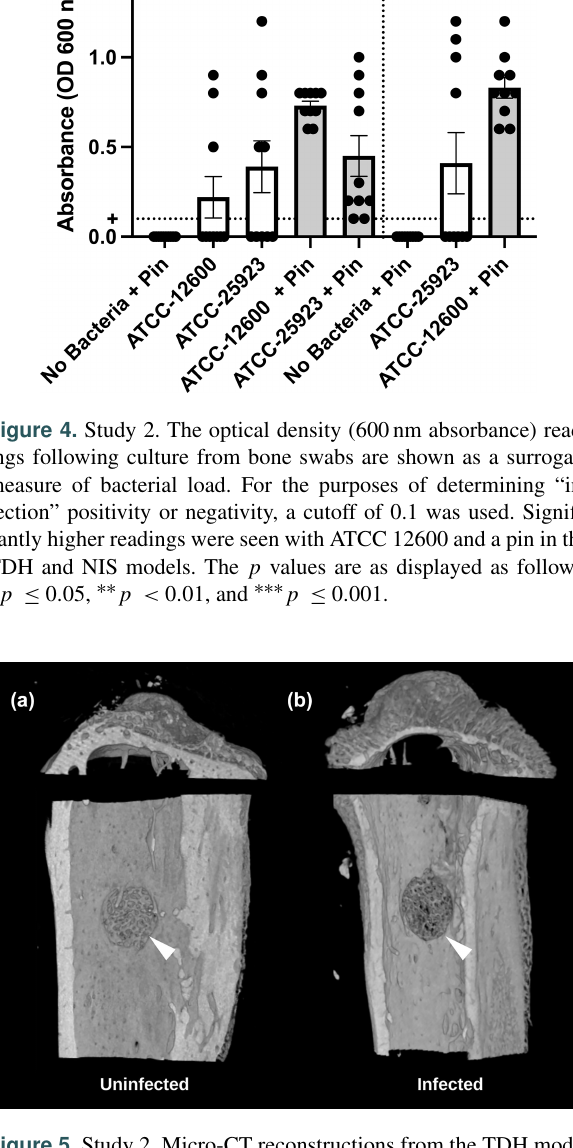
Figure 5. Study 2. Micro-CT reconstructions from the TDH model of the (a) uninfected and (b) infected tibia showing the reduced bone regenerate associated with infection at the defect site (white arrow).